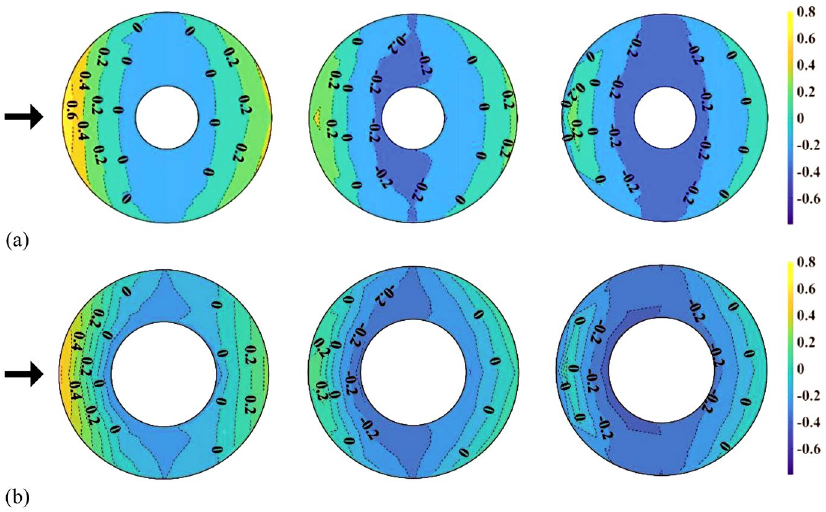
Figure 13. Distribution of C pe,max ( H / D = 0.1, 0.3 and 0.5): ( a ) open ratio of 30% and ( b ) open ratio of 50%.